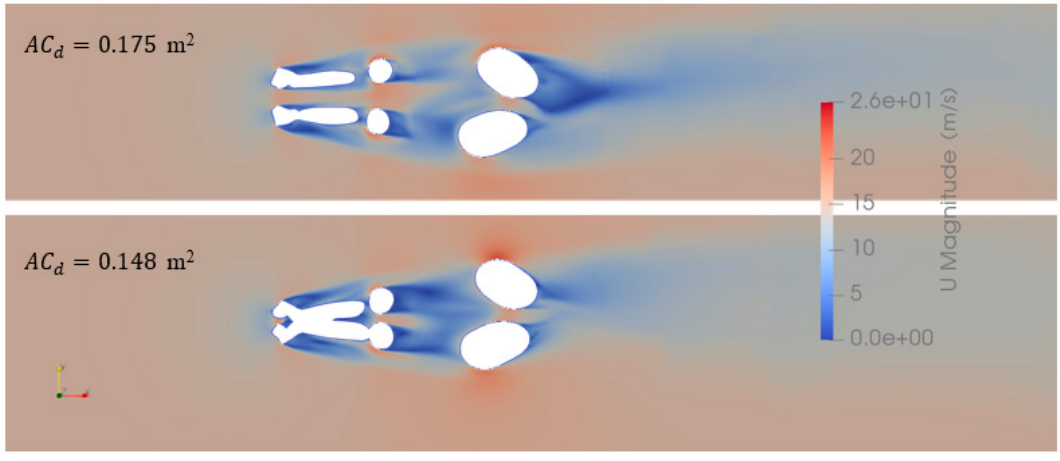
Figure 6. Horizontal slice plot of velocity magnitude comparing influences of underarm separation. Top: Medium shoulder abduction and elbow rotation. Bottom: Base